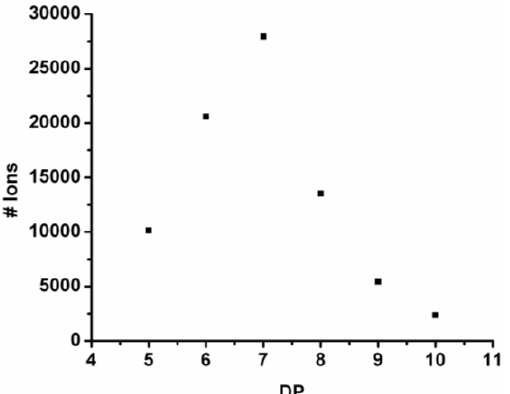
Figure 4. Observed chain length distribution of poly(Tyr-co-Phe).